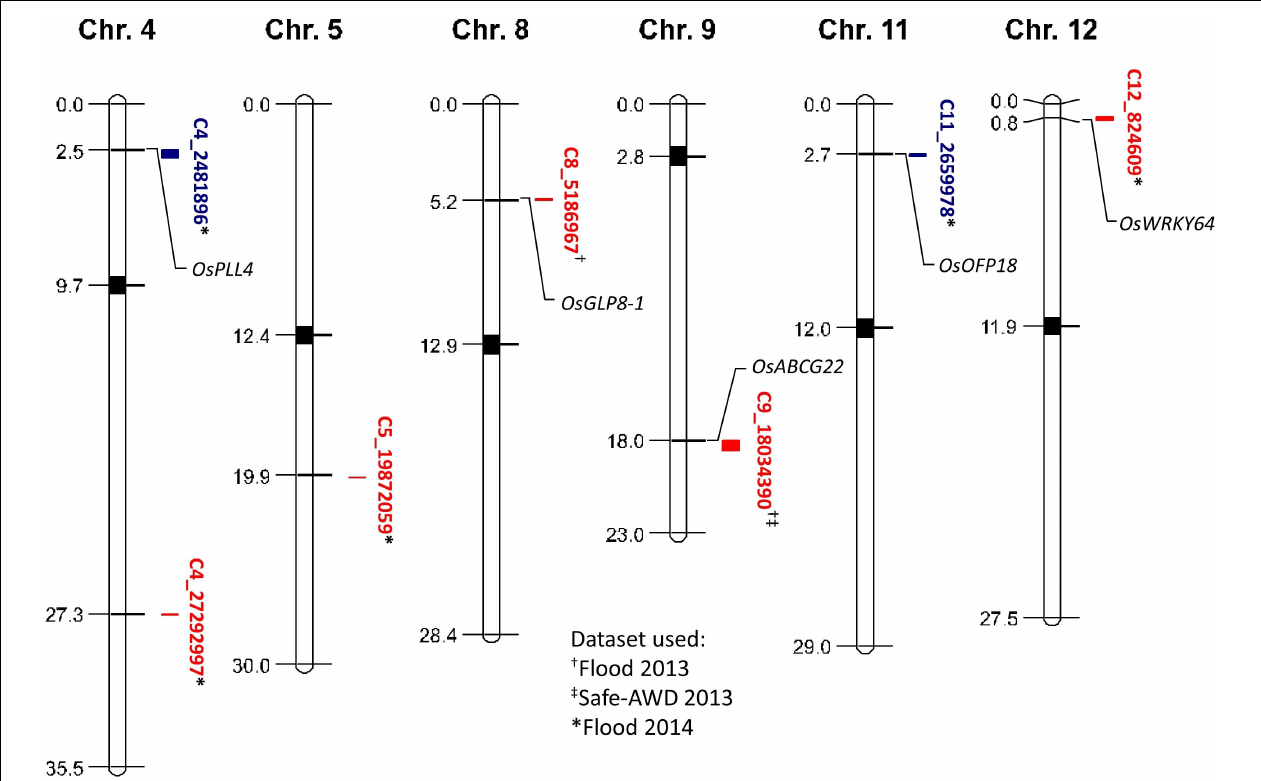
FIGURE 1 | Map of quantitative trait loci (QTLs) affecting brown rice grain inorganic As concentrations and candidate gene locations. Red and blue indicate positive and negative QTL effects on grain iAs levels, respectively. Datasets used to identify QTLs are shown with symbols following the QTL identifier, flood 2013 ( † ), Safe-AWD 2013 ( ‡ ), flood 2014 ( ∗ ). Approximate locations of genes colocalized with the identified iAs affecting QTLs are depicted with italicized gene